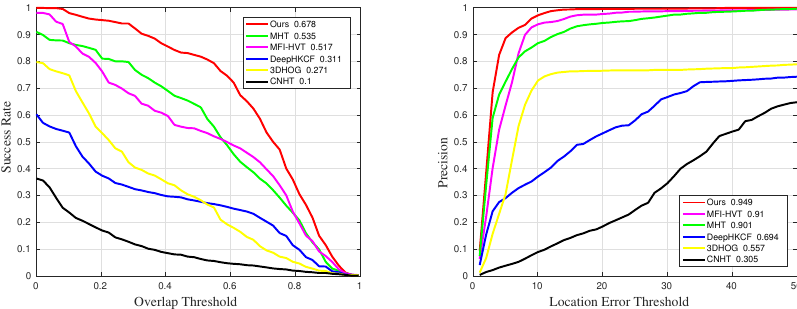
Figure 18. Quantitative results for sequences with challenge